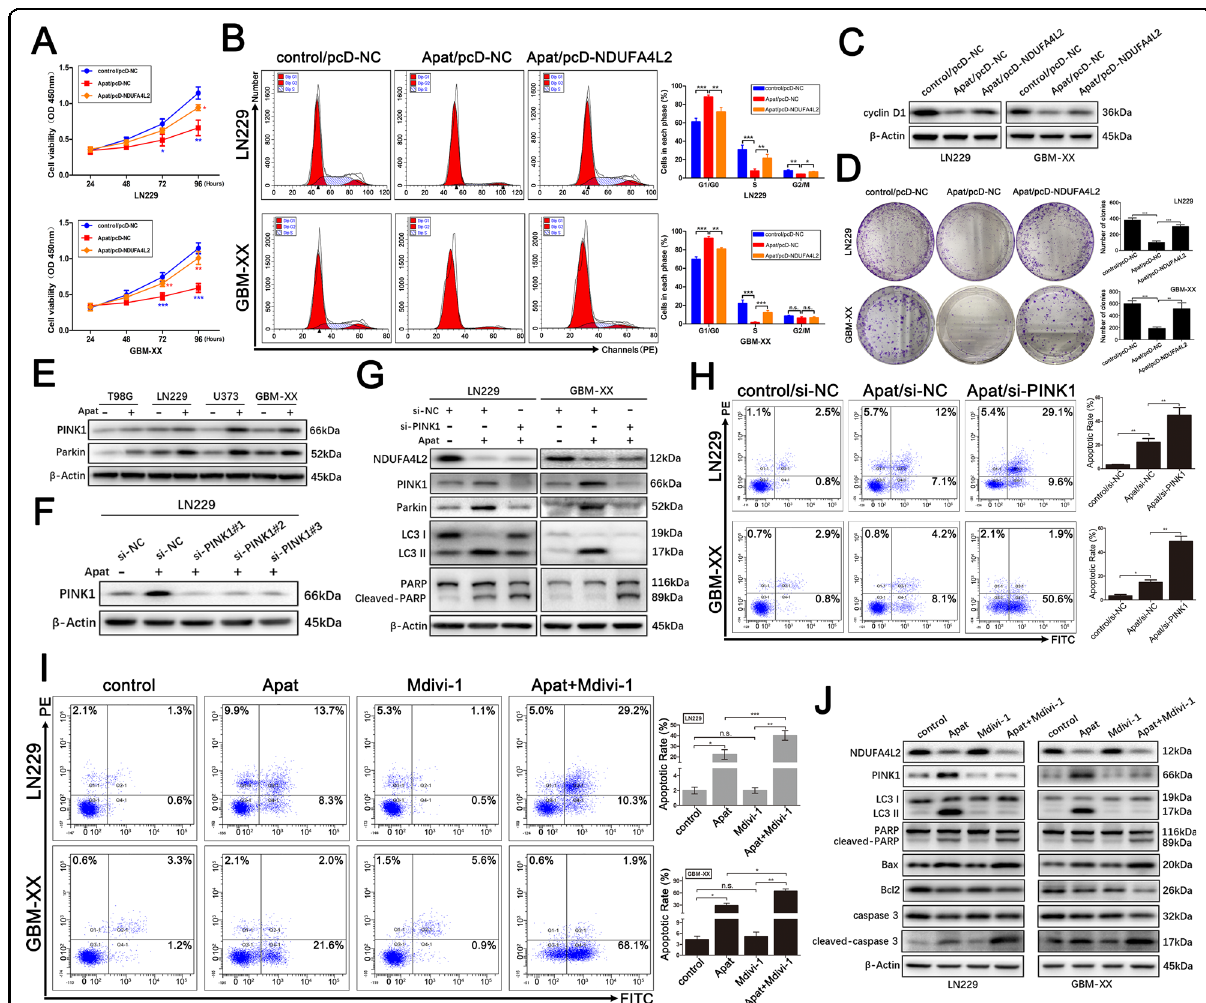
Fig. 5 Apatinib induces cell cycle arrest by targeting NDUFA4L2 and induces apoptosis of GBM cells, which is further enhanced by PINK1 knockdown or treatment with mitophagy inhibitor. A Cell viabilities of pcDNA-NDUFA4L2 or pcDNA-NC-transfected LN229 and GBM-XX cells treated with apatinib (20 μ M) were determined by CCK8 assay. B Cell cycle progression in pcDNA-NDUFA4L2 or pcDNA-NC-transfected LN229 and GBM-XX cells treated with apatinib (20 μ M) were determined by fl ow cytometry. C Protein levels of cyclin D1 in pcDNA-NDUFA4L2 or pcDNA-NC- transfected LN229 and GBM-XX cells treated with apatinib (20 μ M) were determined by western blotting. D Colony formation abilities of pcDNA- NDUFA4L2 or pcDNA-NC-transfected LN229 and GBM-XX cells treated with apatinib (20 μ M) were determined by colony formation assay. E Immunoblot analysis of PINK1 and Parkin protein levels in T98G, LN229, U373, and GBM-XX cells treated with apatinib (20 μ M). F Protein levels of PINK1 in LN229 cells were determined by western blotting. G Protein levels of NDUFA4L2, PINK1, Parkin, LC3, PARP, and cleaved-PARP in si-PINK1 or si-NC-transfected LN229 and GBM-XX cells with apatinib (20 μ M) were determined by western blotting. H Apoptosis rates in si-PINK1 or si-NC- transfected LN229 and GBM-XX cells with apatinib (20 μ M) were determined by fl ow cytometry ( n = 3). I Apoptosis rates in LN229 and GBM-XX cells treated with apatinib (20 μ M), Mdivi-1 (5 μ M), or apatinib + Mdivi-1 was determined by fl ow cytometry ( n = 3). J Immunoblot analysis of NDUFA4L2, PINK1, LC3, PARP, cleaved-PARP, Bax, Bcl2, caspase 3, and cleaved-caspase 3 protein levels in LN229 and GBM-XX cells treated with apatinib (20 μ M), Mdivi-1 (5 μ M), or apatinib + Mdivi-1. Means ± SDs of triplicate experiments are plotted. * p < 0.05, ** p < 0.01, *** p < 0.001, n.s. not